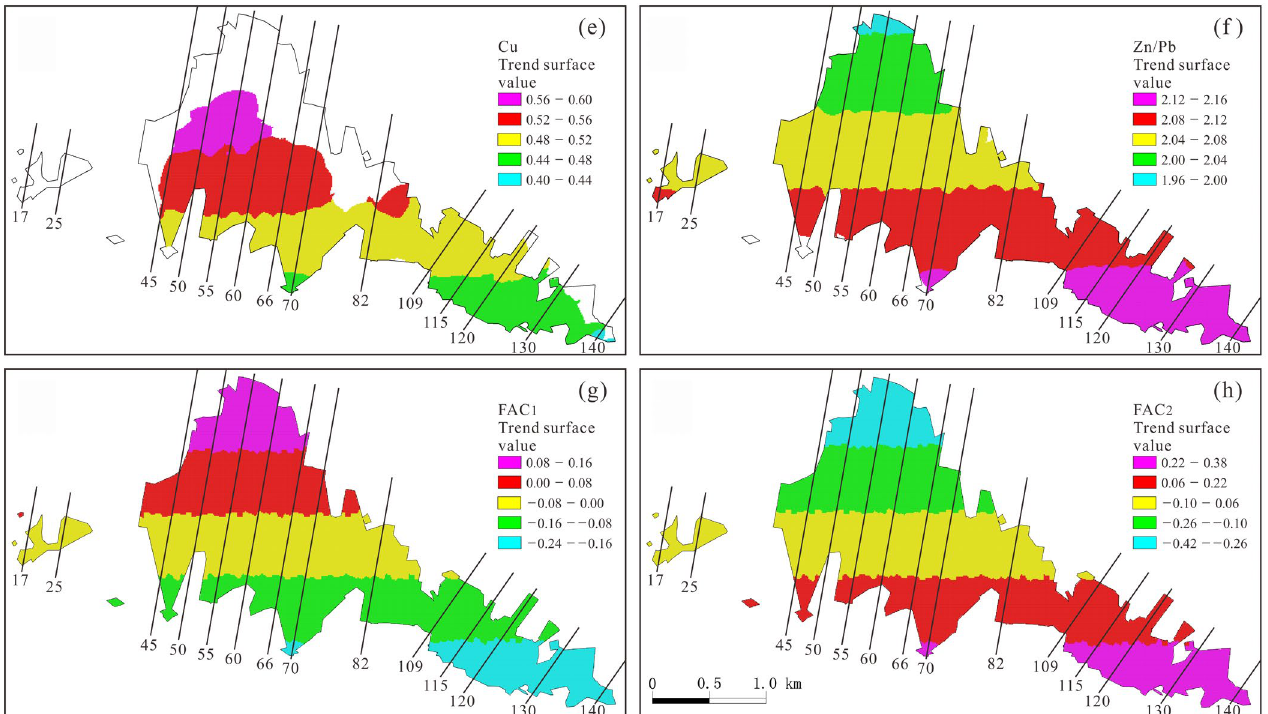
Figure 11. Horizontal projection of the ore body and the first-order trend surface of the mineralization: ( a ) Ag; ( b ) Pb; ( c ) Zn; ( d ) Sn; ( e ) Cu; ( f ) Zn/Pb; ( g ) FAC 1 = medium-temperature factor score; ( h ) FAC 2 = high-temperature factor score.